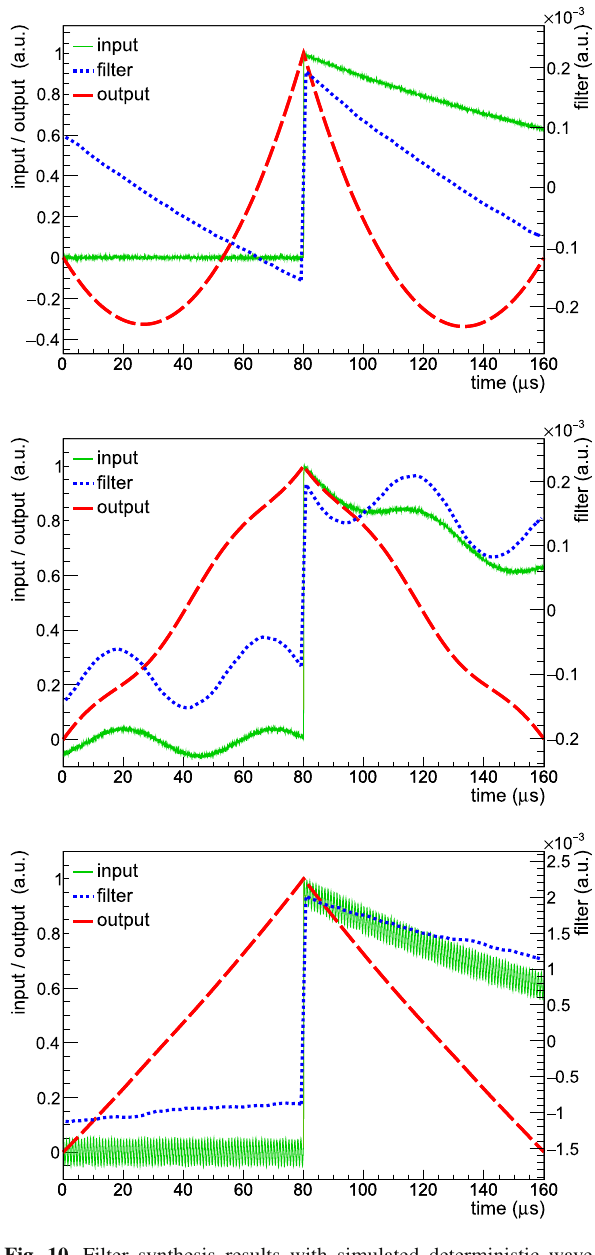
Fig. 10 Filter synthesis results with simulated deterministic wave- forms superimposed to series noise and time-uncorrelated sinusoidal disturbances at 50 Hz frequency (top panel), 20 kHz frequency (middle panel) 1 MHz frequency (bottom panel)